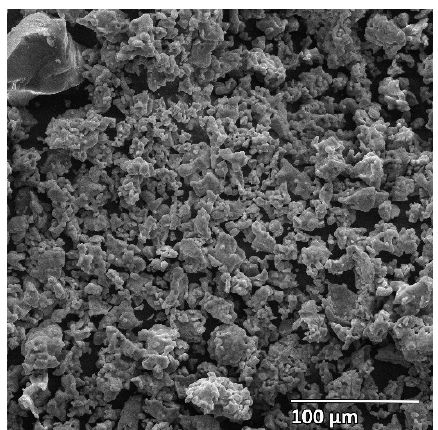
Figure 3. The SEM image for Ca 9 Gd 0.8 Tm 0.1 Sm 0.1 (PO 4 ) 7 .